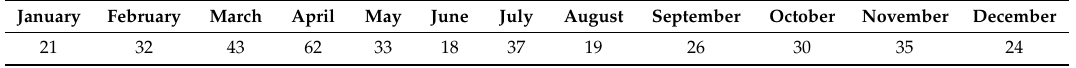
Table 4. Monthly distribution of the 380 days described in the